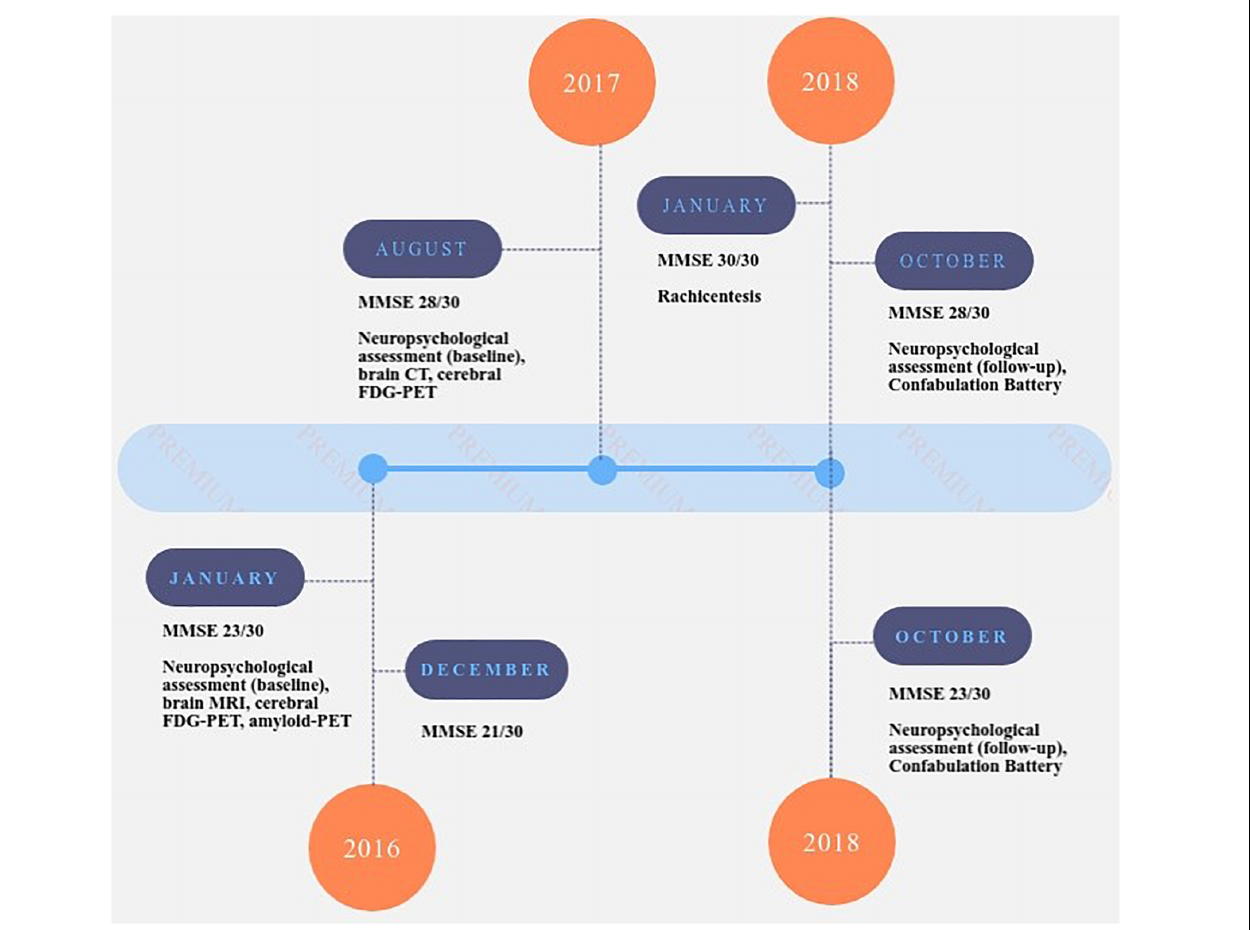
FIGURE 1 | Timeline of events for patient A.R. (upper part of the figure) and A.G. (lower part of the figure). MMSE: Mini Mental State Examination (Folstein et al., 1975; Measso et al., 1993); NPI: Neuropsychiatric Inventory test (sub-items – sub-item delusions, hallucinations, agitation, depression, anxiety, euphoria, apathy, disinhibition, irritability, aberrant motor, night-time behavior, appetite) (Cummings, 1997).